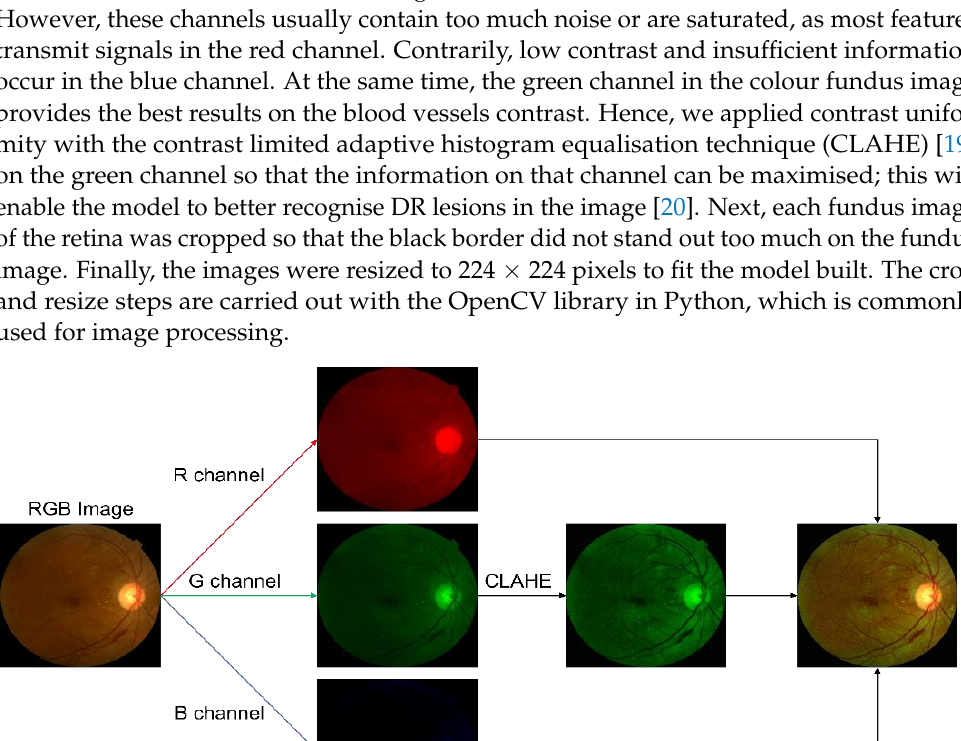
Table 1. DDR dataset composition.